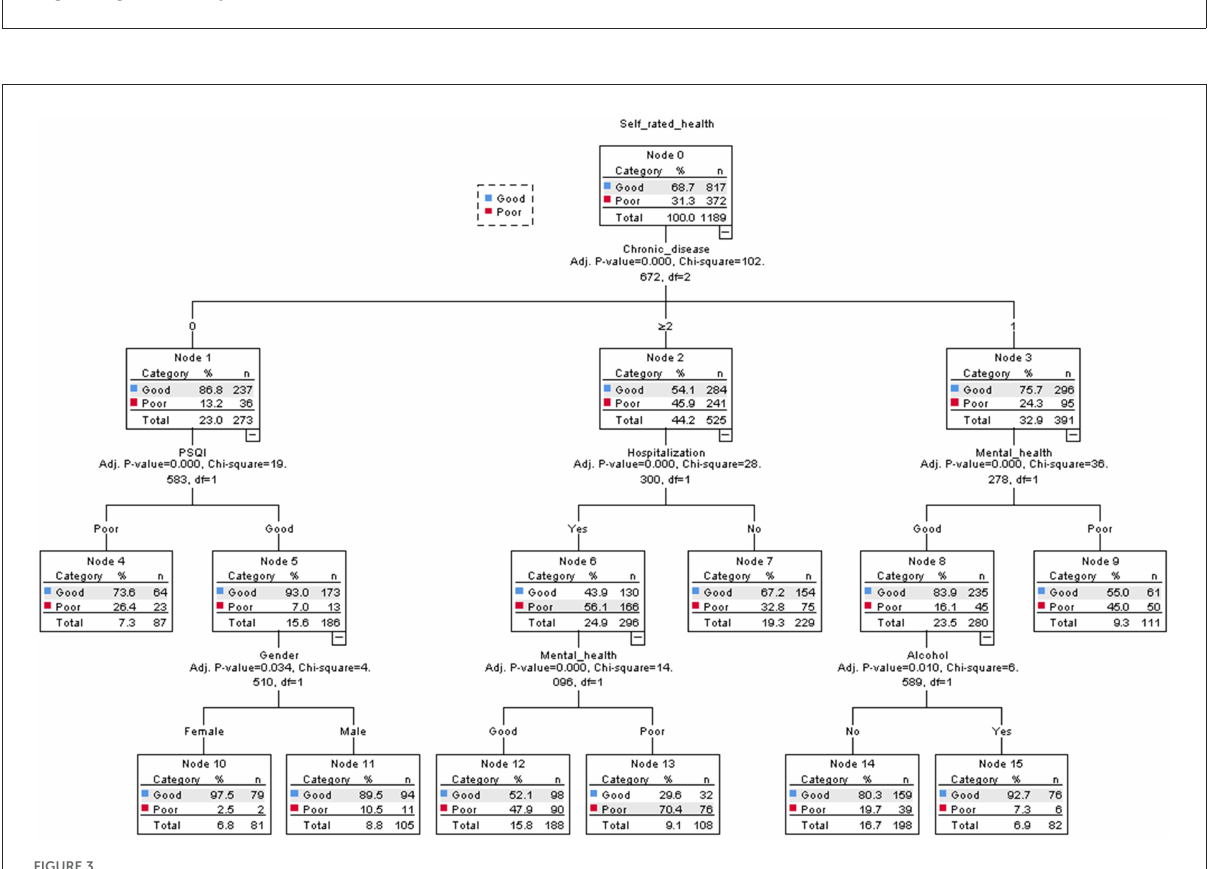
the decision tree model had a sensitivity of 71.5%, a specificity of 61.4%, and the area under the ROC curve was 0.733 (0.703–0.763). The difference between the two models is statistically significant ( Z = − 2.729, P = 0.003), and the prediction effect of the two models was moderate